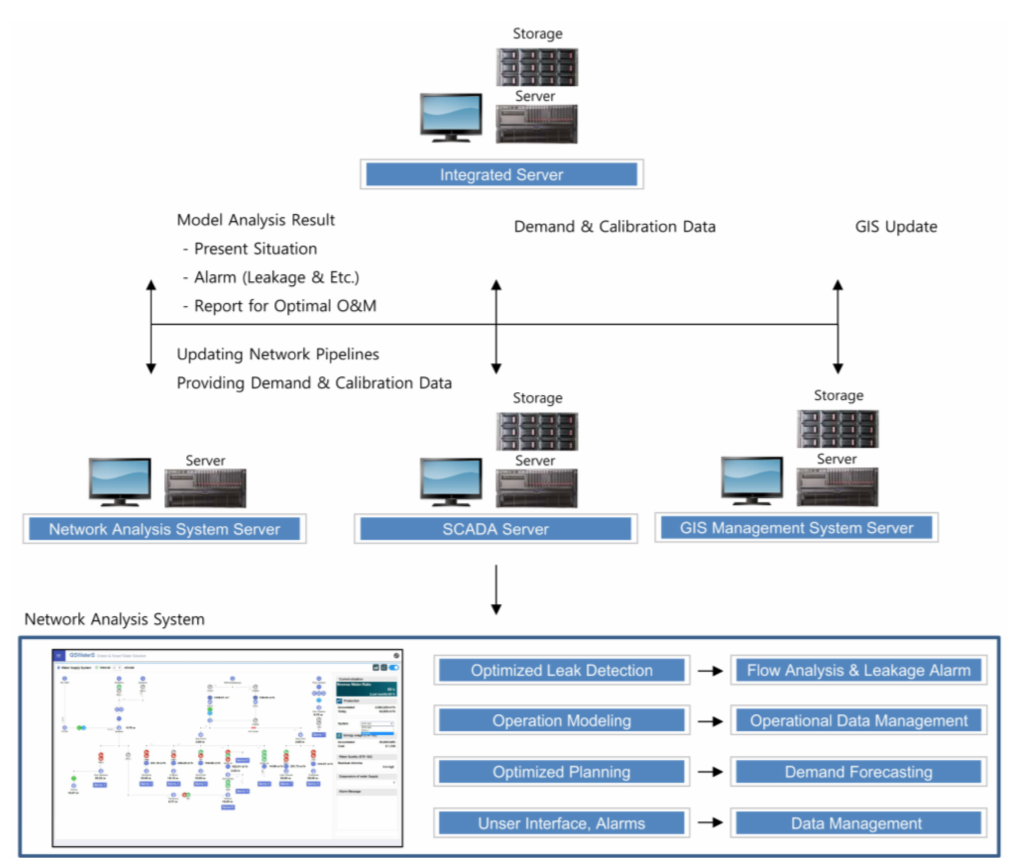
Figure 3. System configuration of the water network system in Aracatuba,